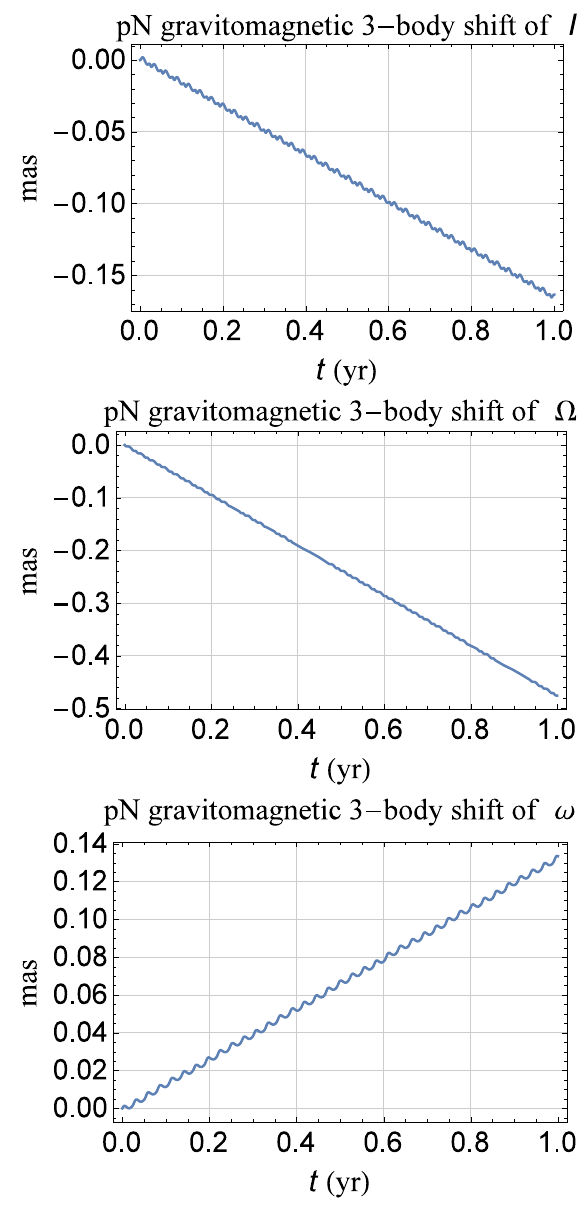
Figure 1. Numerical time series of the pN 3-body shifts of I , Ω , ω of a fictitious test particle moving around a Callisto-like primary M which orbits a Jupiter-type 3rd body X. They were obtained by integrating the equations of motion of the orbiter about M and of M about X in Cartesian rectangular coordinates referred to the Earth’s mean equator at the epoch J2000.0 with and without Equation (18) acting on the test particle. Both runs shared the same set of arbitrary initial conditions for the probe P b = 10.07 d, e 0 = 0.3, I 0 = 80 deg, Ω 0 = 230 deg, ω 0 = 40 deg, f 0 = 50 deg and the primary; the initial state vector of the Callisto-Jupiter relative motion was adopted from the database JPL HORIZONS. For each Keplerian orbital element, its time series calculated from the purely Newtonian run was subtracted from that obtained from the pN integration in order to obtain the signatures displayed here. The resulting rates, in mas year − 1 , agree with those computed in Equations